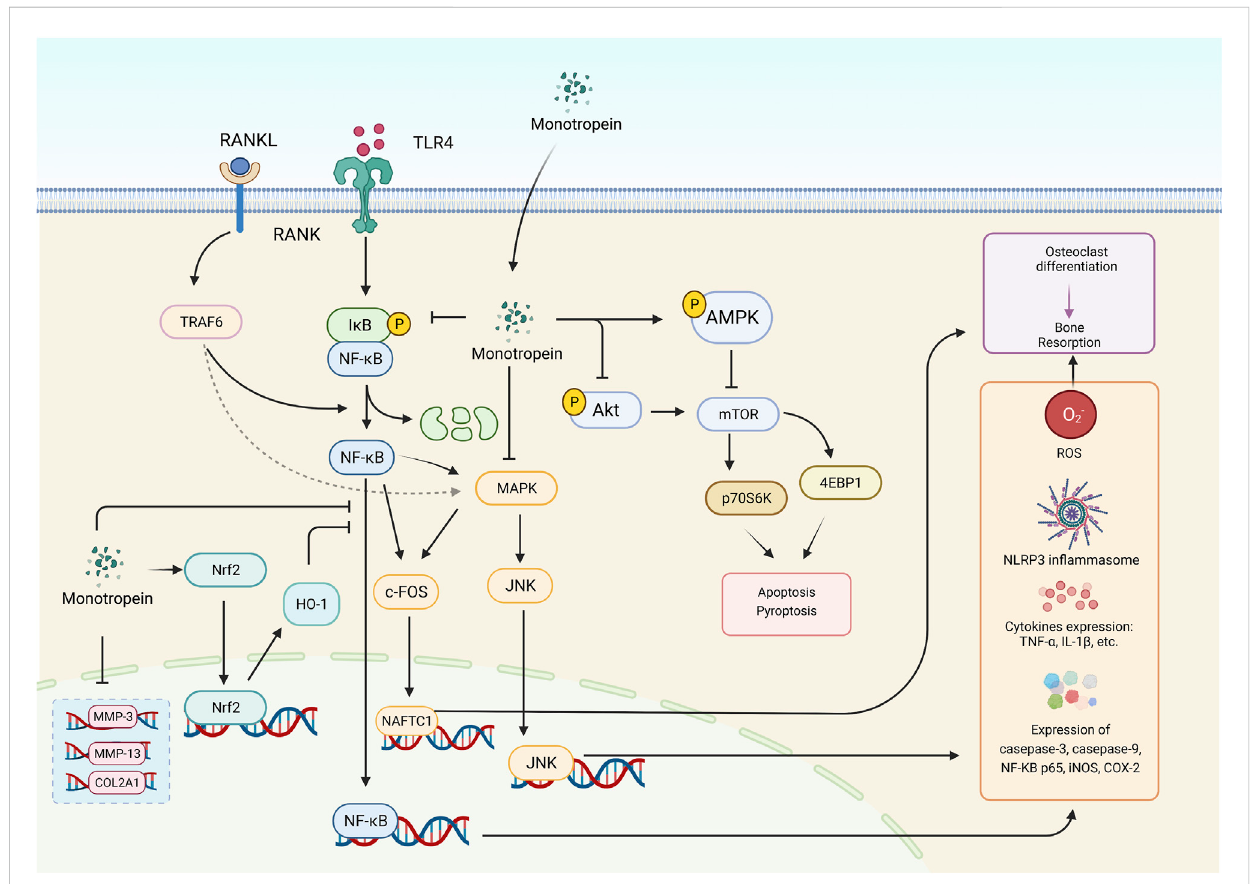
FIGURE 3 The various bioactivities of monotropein are associated with multiple signaling pathways. The crucial signaling pathways were displayed above, including NF- κ B signaling pathway, PI3K-Akt signaling pathway, MAPK signaling pathway (depending on JNK signaling pathway), Nrf2/HO-1 signaling pathway and autophagy signaling pathway. RANKL, receptor activator of nuclear factor- κ B ligand. RANK, receptor activator of nuclear factor- κ B. TLR4, toll like receptor 4. MMP-3, matrix metalloproteinases 3. MMP-13, matrix metalloproteinases 13. Nrf2, nuclear factor E2-related factor 2. HO-1, Heme oxygenase-1. NFATC1, nuclear factor of activated T-cells, cytoplasmic 1. NF- κ B, Nuclear factor- κ B. MAPK, mitogen-activated protein kinase. Akt, protein kinase B. mTOR, mammalian target of rapamycin. p70S6K, p70 ribosomal protein S6 kinase. JNK, c-JunN-terminalkinase. 4EBP1, eukaryotic initiation factor 4E binding protein 1. ROS, reactive oxygen species. iNOS, inducible nitric oxide synthase. COX-2, cyclooxygenase-2. TNF- α , tumor necrosis factor-alpha. IL-1 β , interleukin-1beta. c-FOS, c-FOS protein. COL2A1, collagen Type II alpha 1. TRAF6, TNF receptor-associated factor 6. I κ B, inhibitor of NF- κ B. NLRP3, nucleotide-binding oligomerization domain-like receptor family pyrin domain containing protein